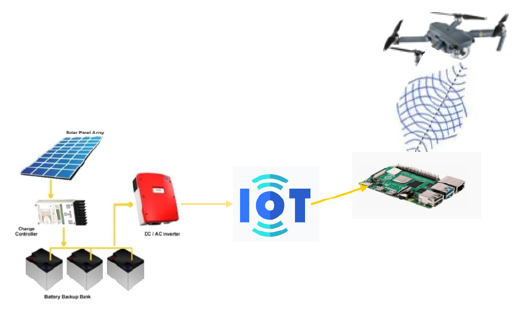
Figure 3. IoT off-grid architecture